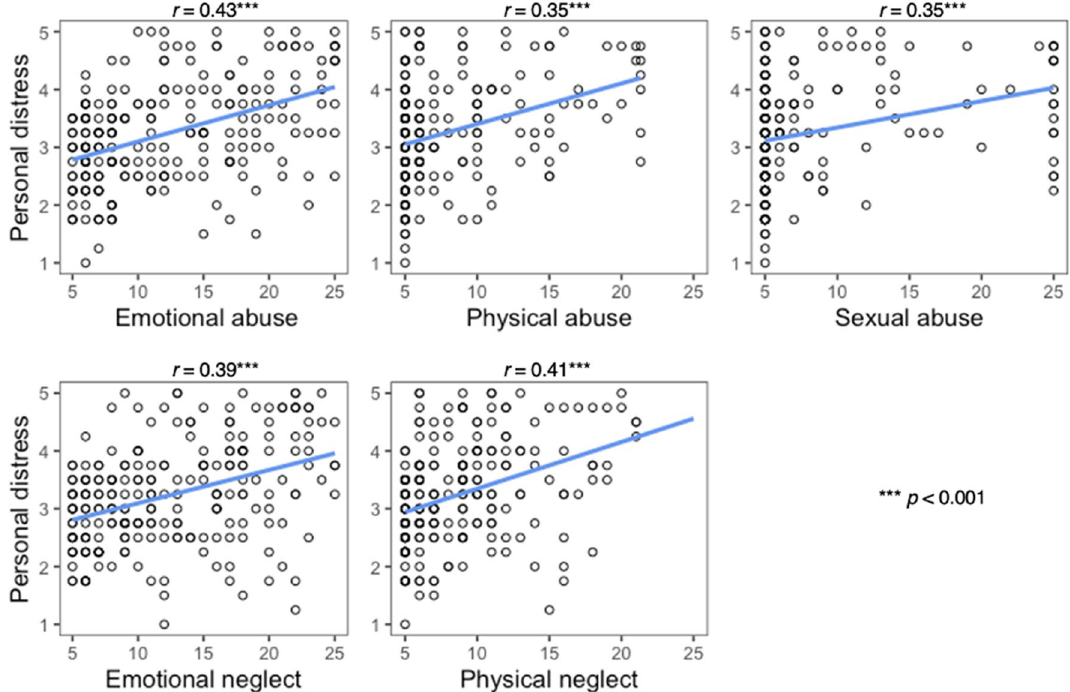
Figure 1. Association between CTQ (= Childhood Trauma Questionnaire) subscales and personal distress in response to others’ suffering.